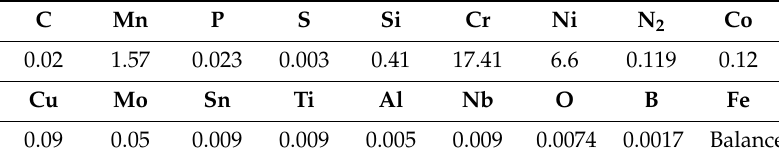
Table 2. Chemical composition of annealed and pickled AISI 301 (mas %). Data from [19].